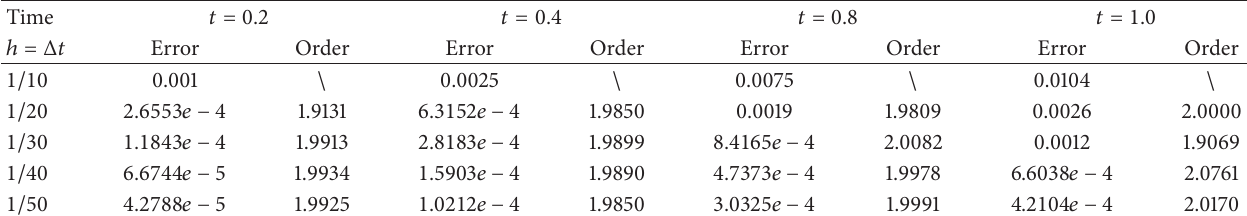
Figure 1: The figures of exact solution 𝑢 and numerical solution 𝑢 ℎ at 𝑡 = 0.5 , 1.0 ((a), (b) for 𝑢 and 𝑢 ℎ at 𝑡 = 1.0 and (c), (d) for 𝑢 and 𝑢 ℎ at 𝑡 = 0.5 ). Table 1: The errors of ‖𝑢 − 𝑢 ℎ ‖ at different